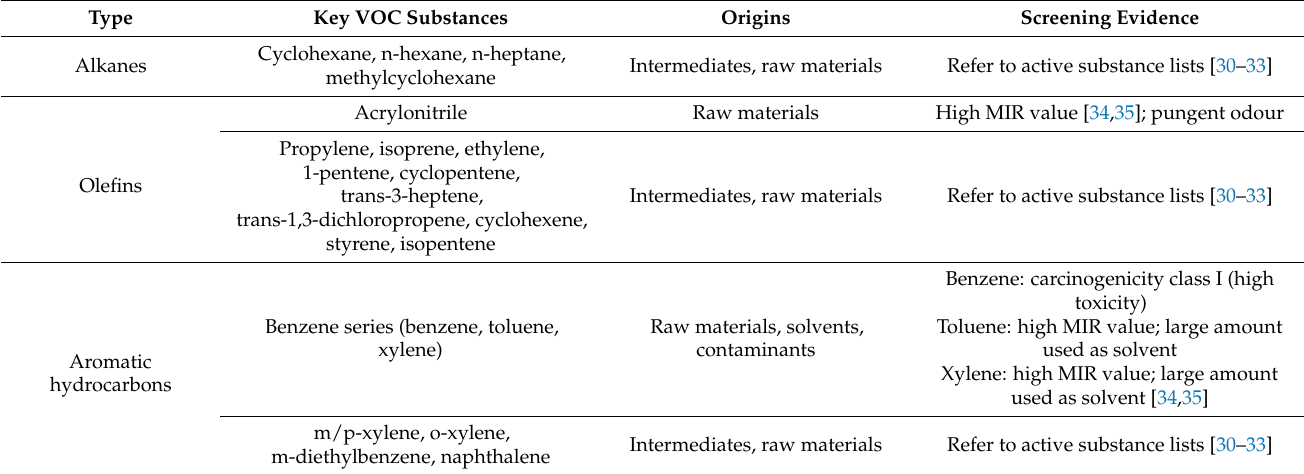
Table 3. List of key VOC substances in the pesticide manufacturing